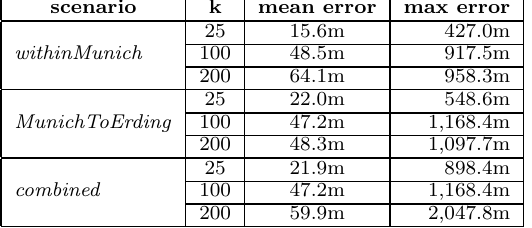
Table 2: Mean and maximum errors using R5r .